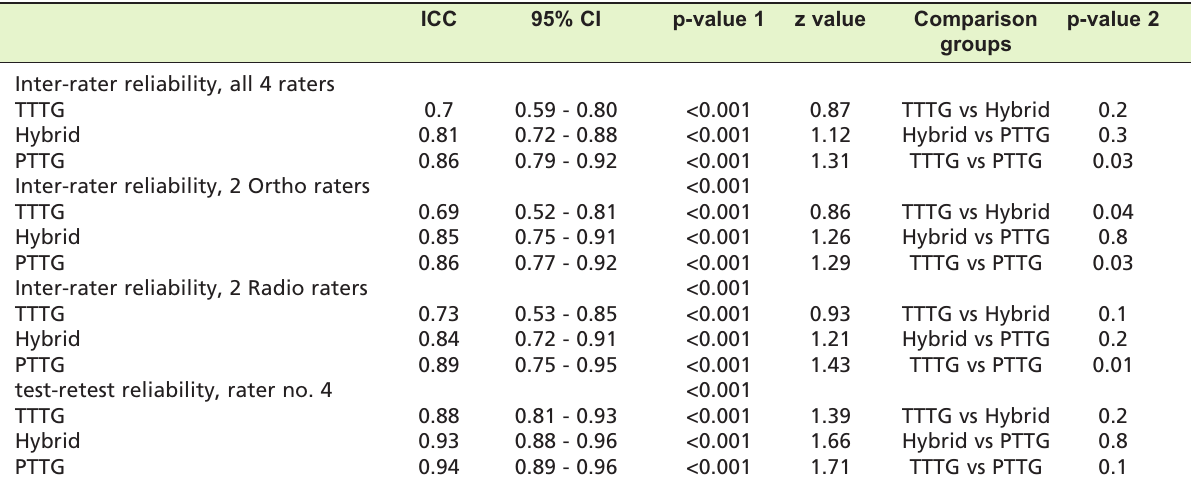
ICC for inter-rater and test-retest reliabilities for the non-PFI group Table II: ICC 95% CI p-value 1 z value Comparison p-value 2